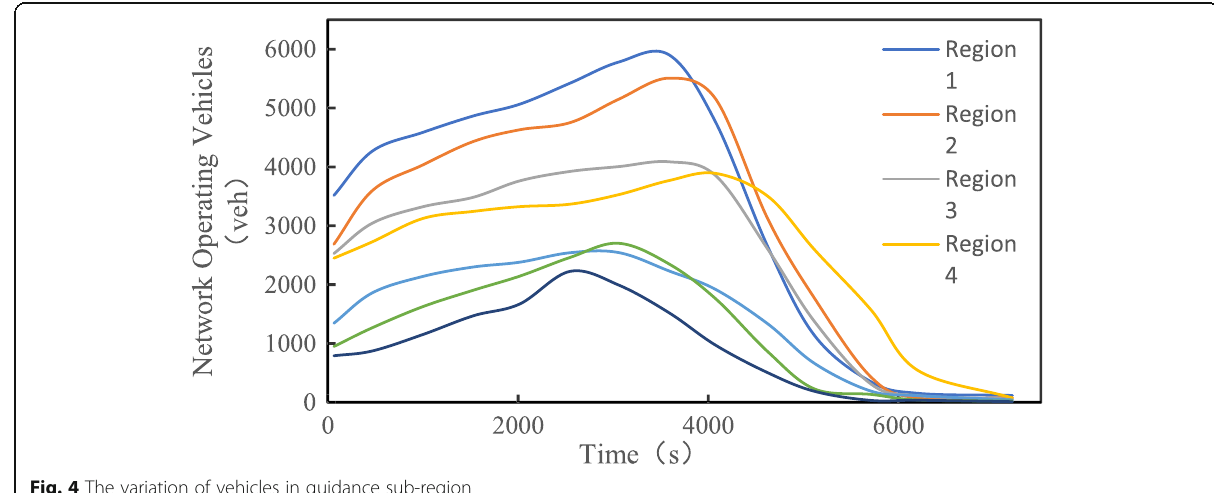
Fig. 4 The variation of vehicles in guidance